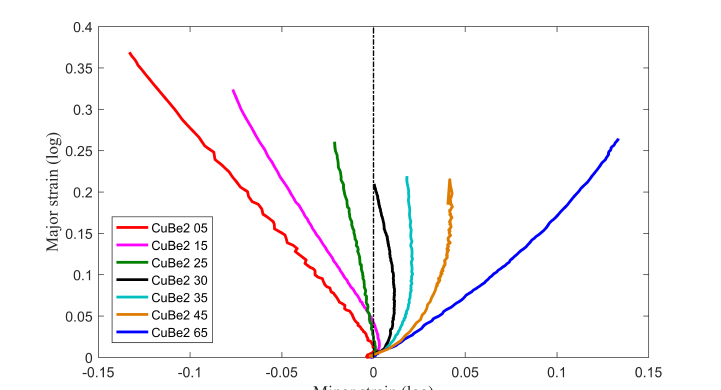
Figure 5. Evolution of major-minor strains of pure copper specimens from 5 mm width (Cu 05) to 65 mm (Cu 65) in the Nakazima tests.